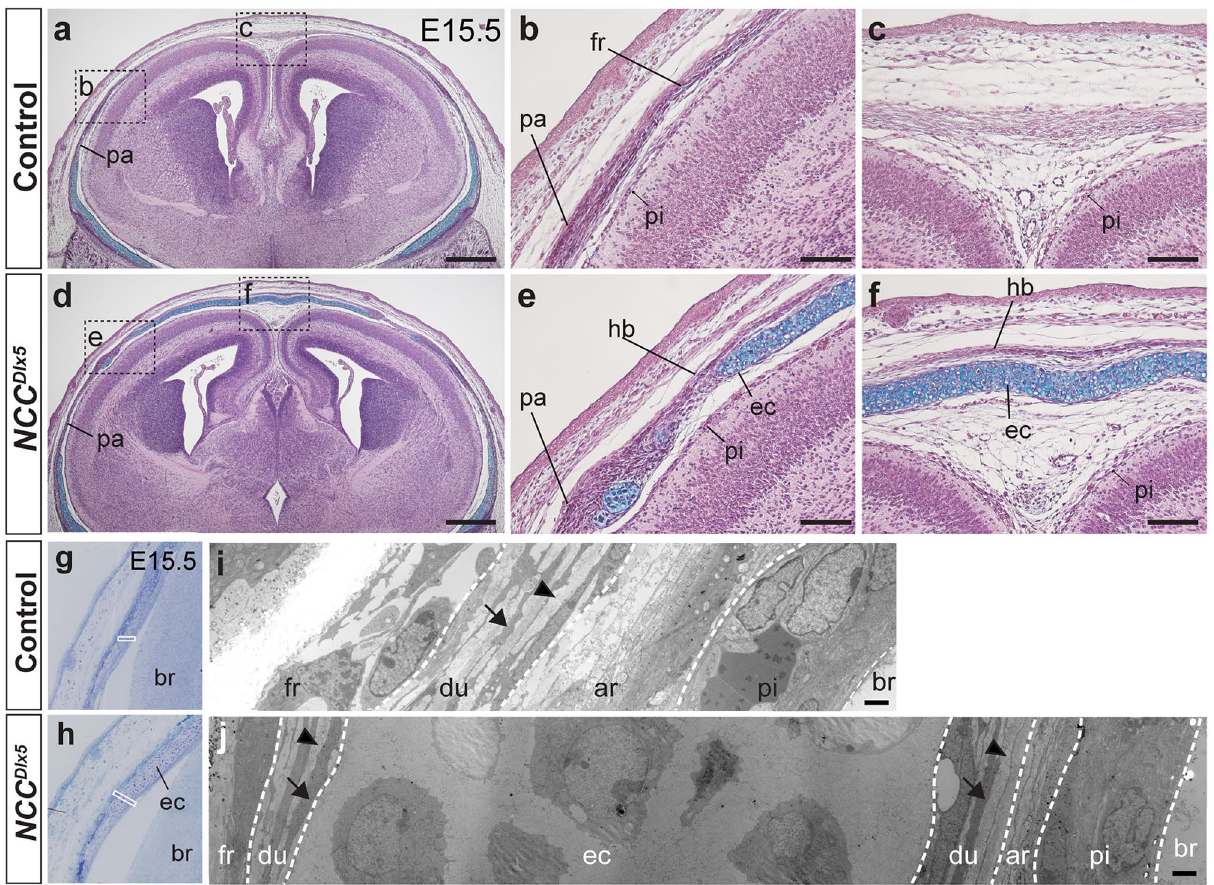
Figure 4. Histological analysis of the ectopic cartilage and heterotopic bone in the NCC Dlx5 at E15.5. ( a – f ) Frontal sections of E15.5 control ( a – c ) and NCC Dlx5 ( d – f ) stained by HE and Alcian blue. ( b , c , e , f ) are high magnification images of boxed areas in ( a , d ). Heterotopic bone is induced at the vertex of the NCC Dlx5 , ectopic cartilage locates under the bone forming layer ( e , f ). ( g, h ) Semi-thin sections stained by toluidine blue on frontal sections of the control ( g ) and the NCC Dlx5 ( h ). ( i, j ) TEM analysis of the control ( i ) and the NCC Dlx5 ( j ) at the white boxed areas in ( g , h ). Arrows and arrowheads in ( i , j ) point to longitudinal-arranged fibroblasts and collagen fibrils, respectively. Ectopic cartilage appears in the meninges and is flanked by dura mater ( j ). ar, arachnoid mater; br, brain; du, dura mater; ec, ectopic cartilage; fr, frontal bone; hb, heterotopic bone; pa, parietal bone; pi, pia mater. Scale bars; 500 μm ( a , d ), 100 μm ( b , c , e , f ), 2 μm ( i , j